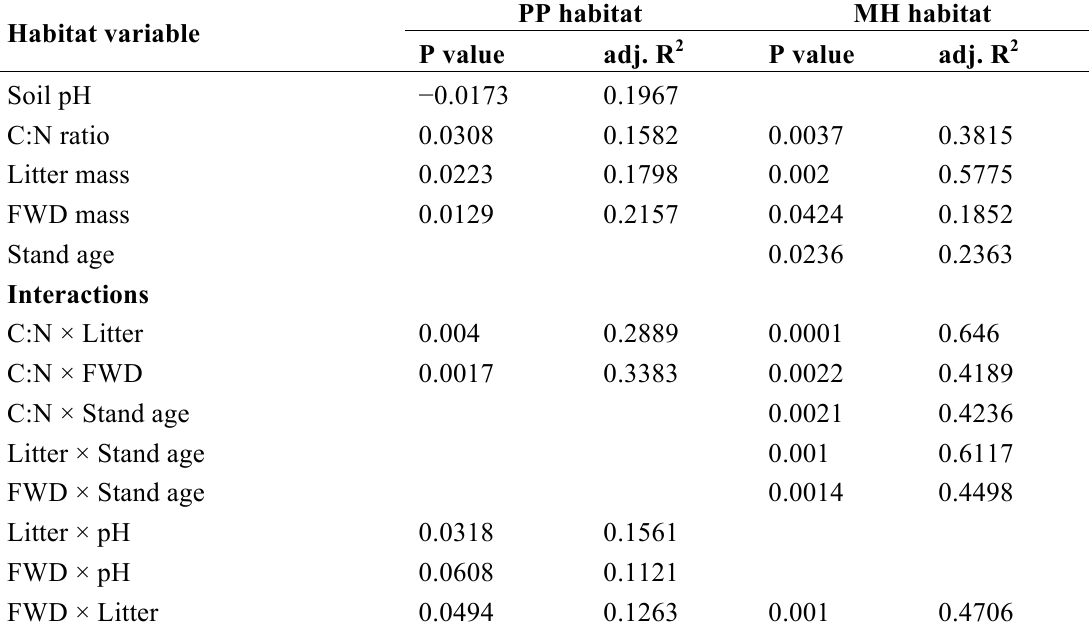
Table 3 . Linear regressions between habitat variables and abundance of mat-forming taxa, by habitat type. Only values significant at α < 0.1 are displayed. A negative sign indicates a negative correlation. PP = ponderosa pine habitat, MH = mountain hemlock habitat, CWD = coarse woody debris, FWD = fine woody